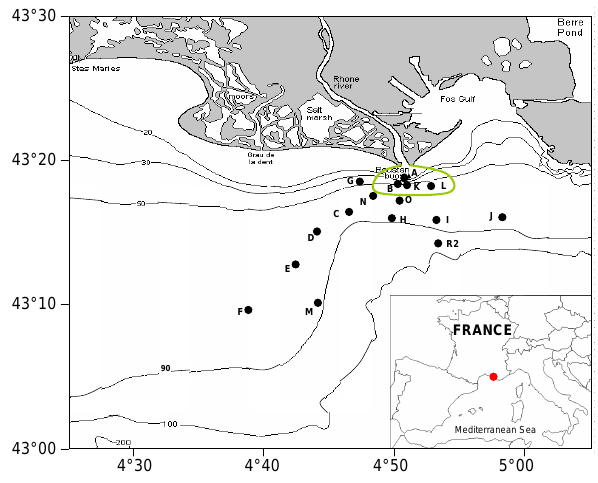
Fig. 1. Map of the Rhˆone River delta including the locations of sampling stations (April 2007). The green line defines the prodelta area of this